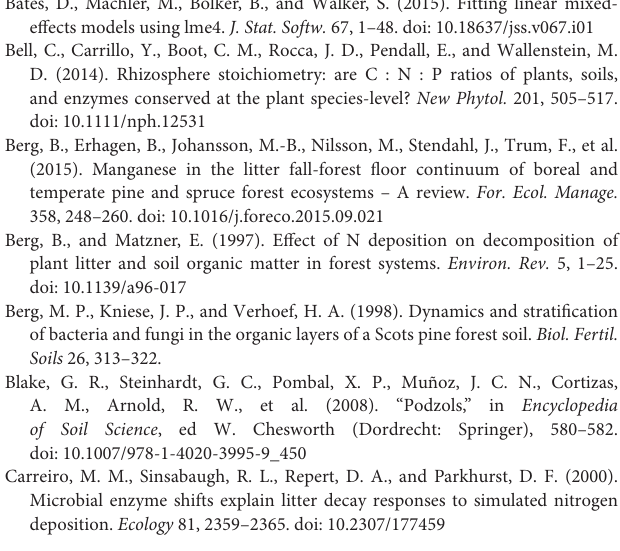
Table S3 | Activities of seven soil enzyme classes involved in organic matter decomposition in response to long-term N addition at Alptal (Switzerland) normalized to soil organic carbon (SOC) concentrations. Table S4 | Activities of seven soil enzyme classes involved in organic matter decomposition in response to long-term N addition at Klosterhede (Denmark) normalized to soil organic carbon (SOC) concentrations. Figure S1 | Relation between the fungi-to-bacterial (F:B) ratios and microbial biomass C:N at Alptal (A) and Klosterhede (B,C) across organic (B) and mineral horizons (A,C) . Microbial biomass C:N is unrelated to F:B ratios across mineral horizons, while the weak, positive relation across organic horizons is affected by N. Figure S2 | Soil microbial communities are strictly C:N homeostatic with respect labile (extractable) resources across the topsoil profile at Alptal (A) and Klosterhede (B) . See Figure 6 for details on